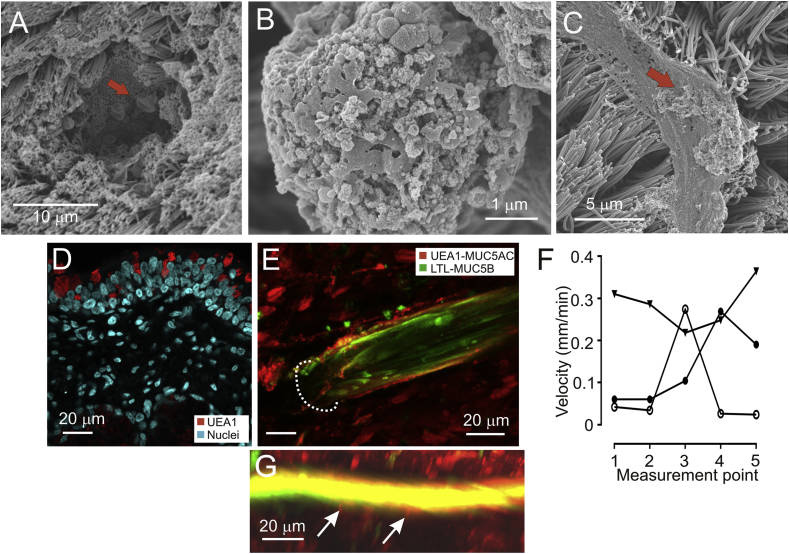
Mucus bundles have a core of MUC5B and are coated with MUC5AC. A. Goblet cell in gland opening (red arrow), SEM. B. Close-up of a secreting surface goblet cell. C. Mucus bundle with attached material (red arrow, SEM). D. UEAI lectin (red) stains surface goblet cell mucins (MUC5AC). E. Pig trachea stained with lectins LTL and UEAI. The bundle consists of an LTL-stained core and coated in UEAI-stained material. The dashed line indicates the gland opening. F. Examples of the variable transport speed of Alcian blue-stained mucus bundles measured at five points evenly spaced along each individual bundle in pig trachea (31 bundles from 3 pigs). G. Pig trachea stained with LTL (green, MUC5B) and UEAI (red, MUC5AC) reveals MUC5AC coming from goblet cells (arrows).